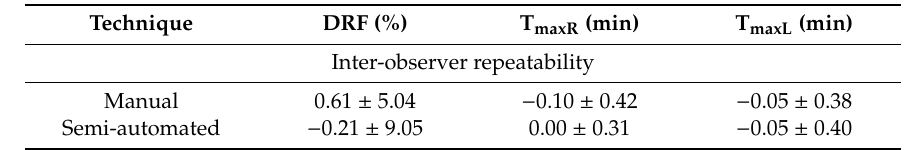
Table 5. Inter-observer repeatability data for DRF, T maxR and T maxL according to the Bland–Altman analysis (mean ± 1.96 SD of the di ff